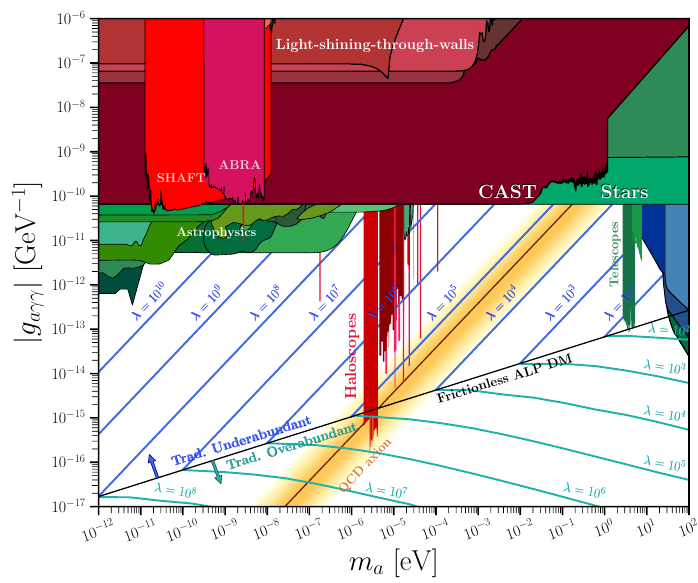
Figure 1 . Axion coupling to photons g aγγ ∼ α/ (2 πf a ) versus its mass for the case where the axion couples to two separate non-abelian gauge groups as studied in section 5. The presence of friction can open up the ALP-dark-matter parameter space: for different values of the enhancement parameter λ , the correct ALP DM relic density is obtained for the traditionally underabundant region along the blue lines and for the traditionally overabundant region along the cyan lines (assuming α = 0 . 1 and g (10) , see section 5 for details). Experimental bounds adapted thr ρ,s ∼ O from AxionLimits